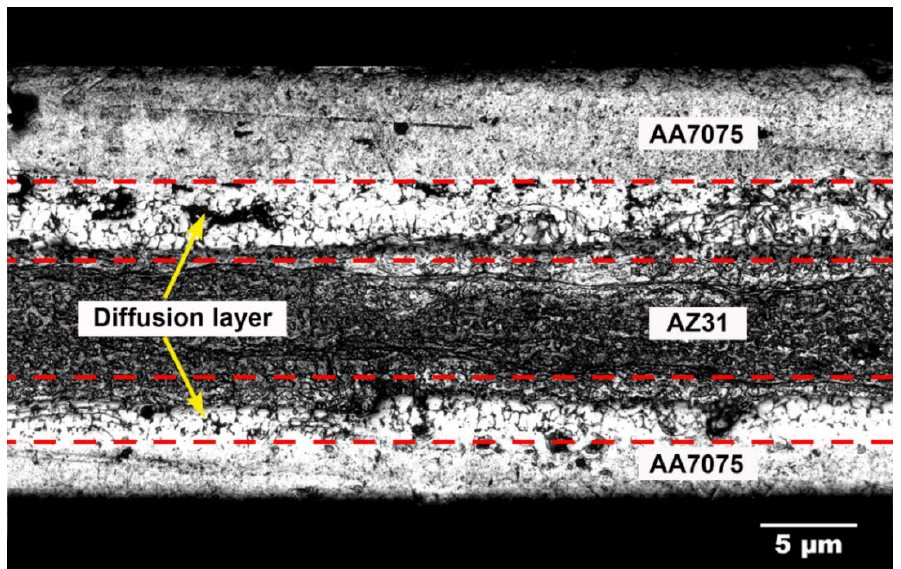
Fig. 2. Cross-sectional view of the Al-alloy/Mg-alloy/Al-alloy sandwich